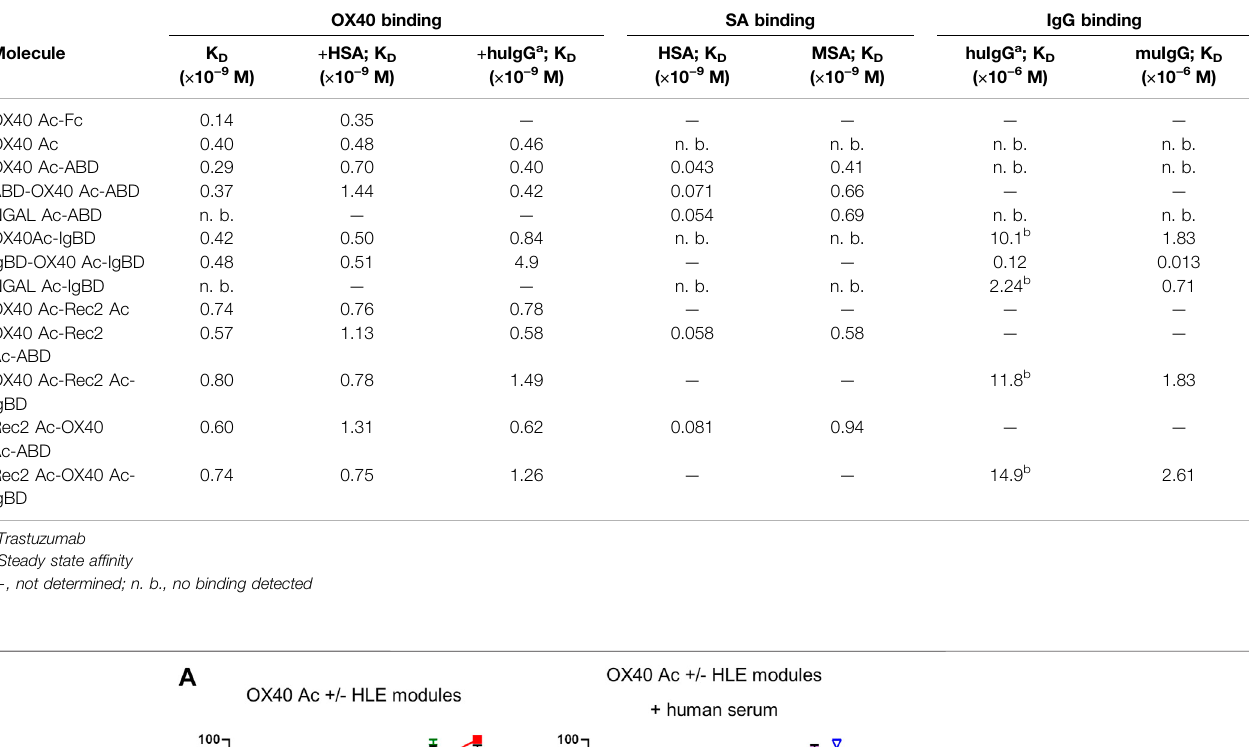
TABLE 2 | K D values of Anticalin proteins binding to OX40 receptor or serum proteins as determined by SPR. OX40 binding SA binding IgG binding Molecule